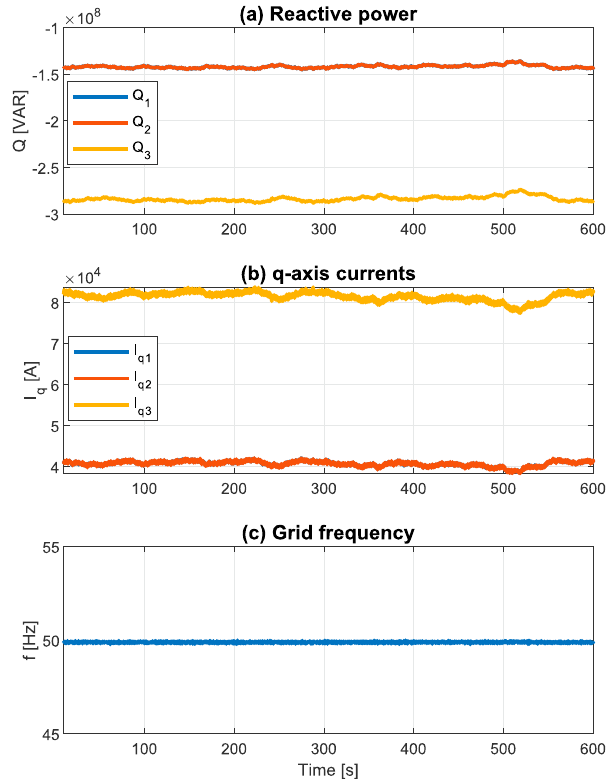
Figure 18. ( a ) Reactive power and ( b ) q-axis currents supplied by the individual inverters; ( c ) grid frequency.